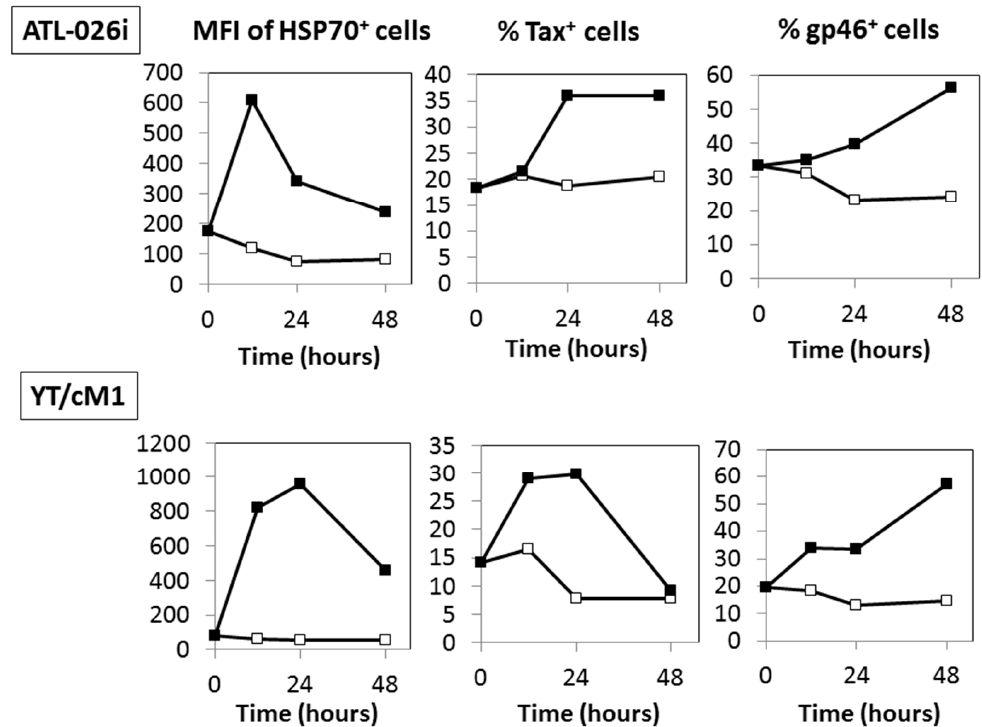
Figure 4. A comparison of time course of the expression among HSP70, Tax and gp46 antigens followed by exposure to HS: The ATL-026i (upper panel) and YT/cM1 (lower panel) cells were either exposed to HS (black square) or mock treated (open square), cultured for 12, 24 and 48 h, and then their phenotypes were analyzed by FCM. Data shown are representative of three independent experiments.